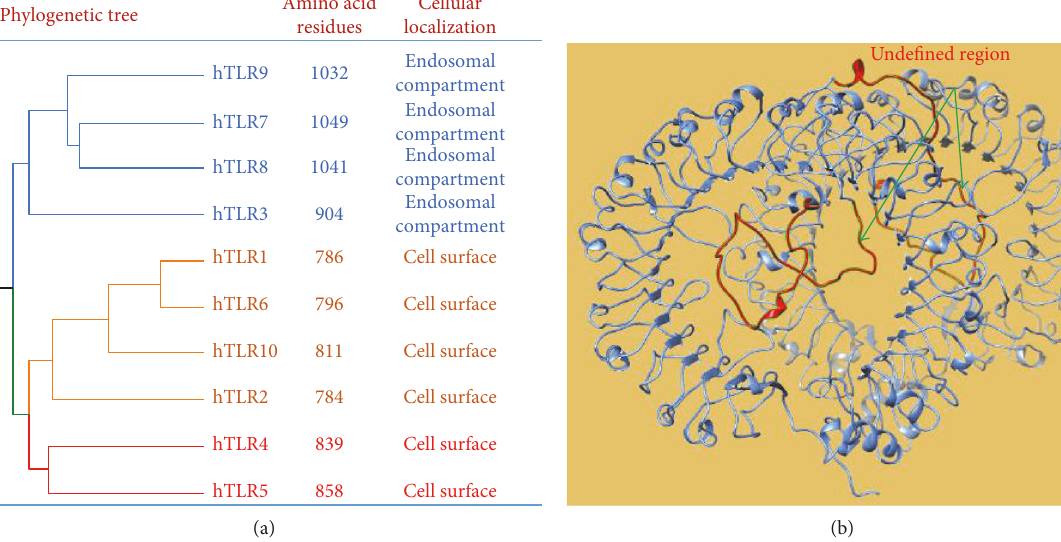
Figure 2: Subfamilies and the extracellular structure of human TLRs. (a) Human TLRs are divided into three phylogenetic subfamilies shown with di ff erent colors. The number and cellular location of amino acid residues are shown in the middle and right columns, respectively. (b) Computational modeling of the ectodomain structure of dimerized TLR7. Blue color shows the horseshoe-shaped solenoid structure of TLR ectodomain. Arrowheads indicate unde fi ned regions (red